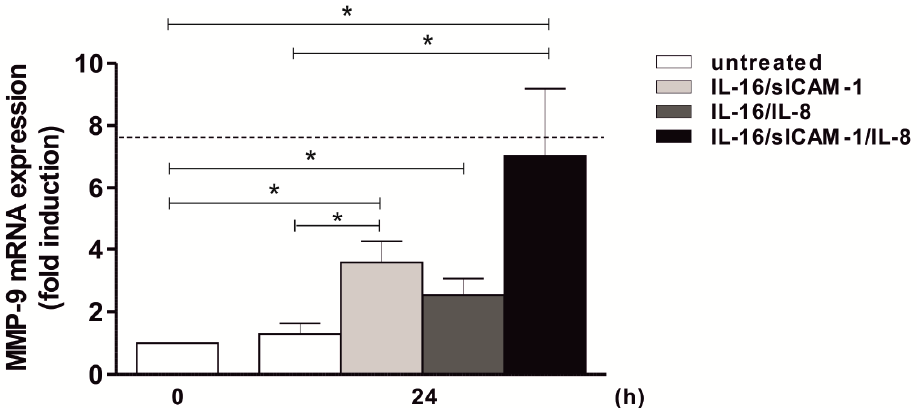
Figure 6. Induction of MMP-9 expression by IL-16, sICAM-1, and IL-8 in THP-1 cells. 2 × 10 6 THP-1 cells/well were starved overnight. Afterwards, cells were stimulated with the mediators identified via Proteome Profiler Array: IL-16 and sICAM-1, IL-16 and IL-8, or IL-16, sICAM-1, and IL-8 for 24 h (5 ng/mL each). The dashed line indicates MMP-9 mRNA expression following TNF stimulation for 2 h as a positive control. MMP-9 mRNA expression was determined using qPCR (QuantiTect Custom Assay; housekeeping gene: GAPDH); mean ± SD, n = 3 (measured in duplicates). T test, * p ≤ 0.05.